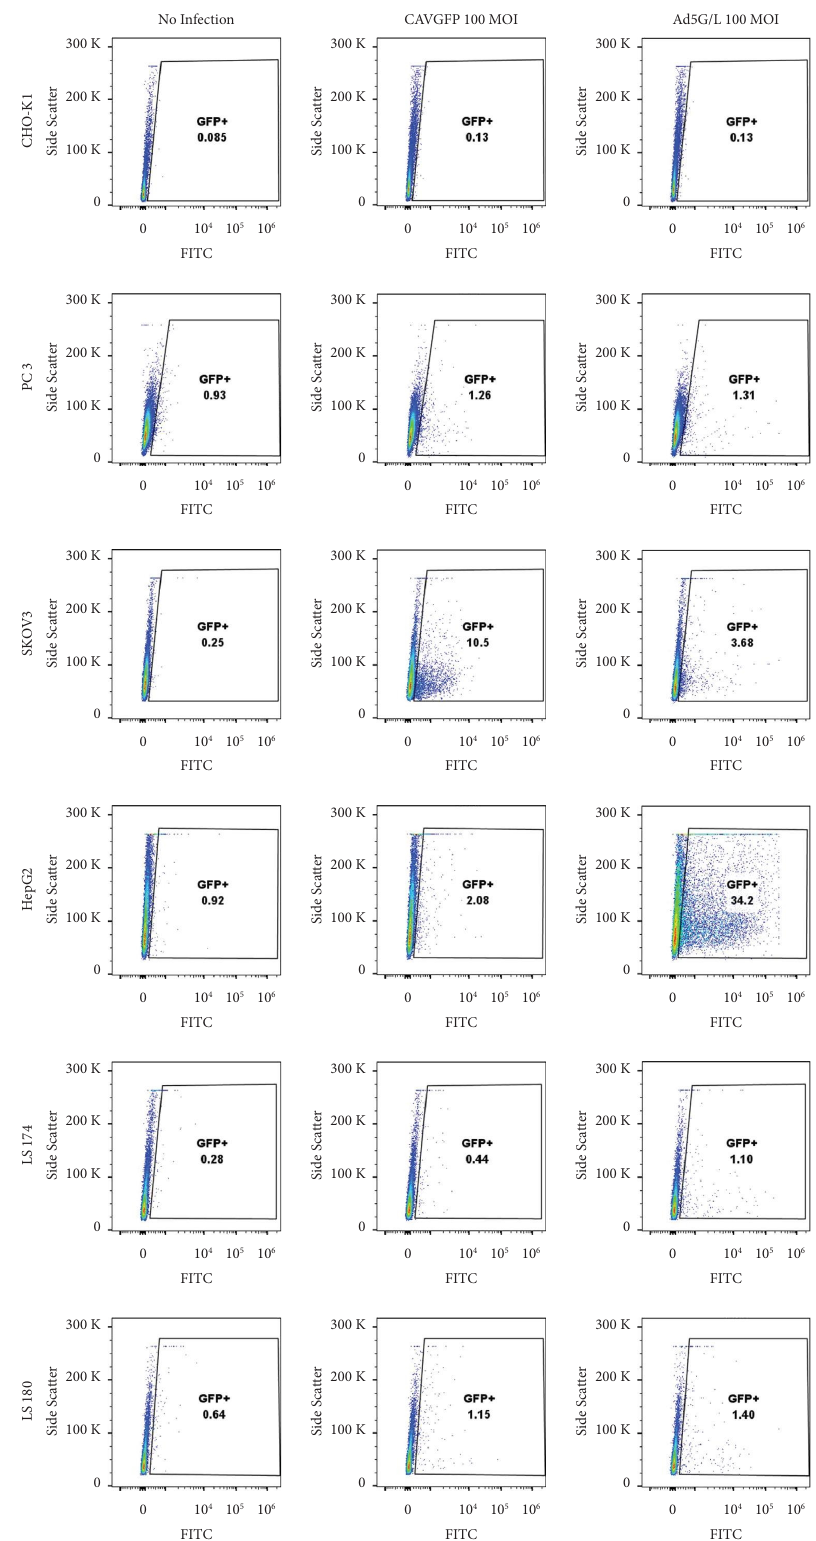
Figure 4: GFP Expression analysis in Chinese Hamster Ovary CHO K1 cells and human cell lines PC3, SKOV3, HepG2, LS 174, and LS 180 at 100 MOI by fow cytometry. Cells were transduced by Adenovirus CAV2 and Ad5G/L at 100 multiplicity of infection (MOI 100:100 virus particles per cell). GFP expression in cells was analyzed by fow cytometry 48 hours after Ad5G/L infection. Te cell population was gated for live and single cells. Te GFP+cells were determined in comparison to cell with no adenovirus infection. Tis fgure is a representative of three independent infection